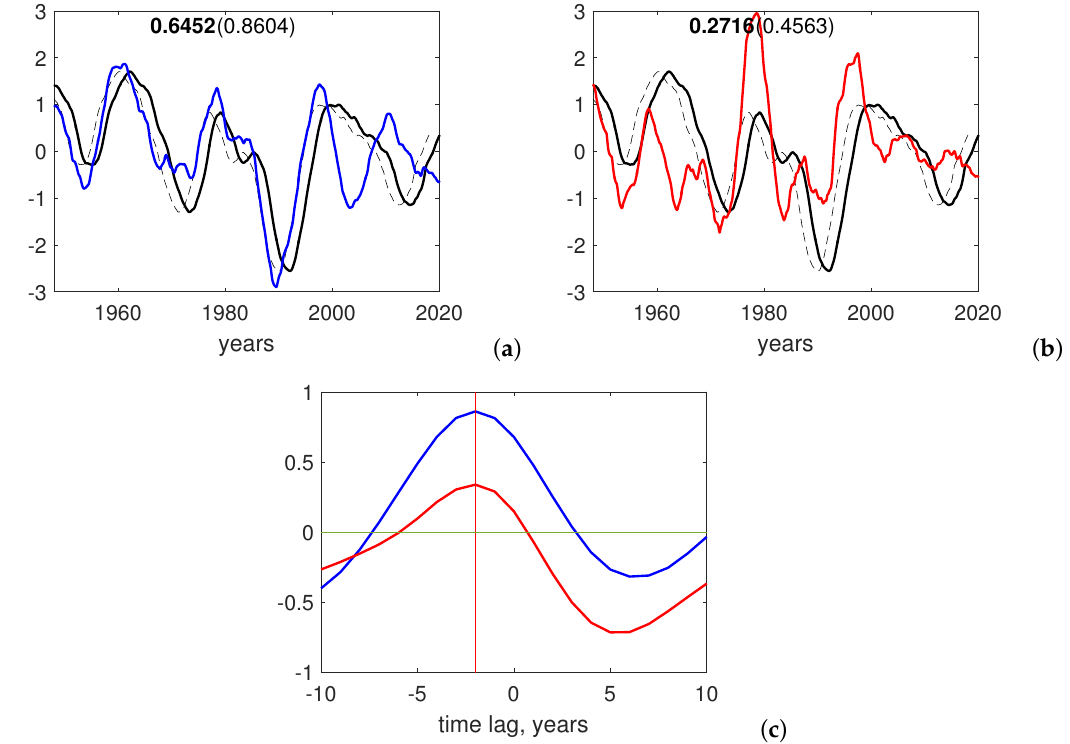
Figure 10. Time change in the rate of total ice growth averaged over the selected areas in comparison with the time variations of the third EOF mode principal component (black): ( a ) the ice growth rate in the region A (blue), ( b ) the rate of decrease in ice thickness in the region B (red), ( c ) the value of the correlation coefficient of these time-series with the principal component depending on the time lag (in years). The geographical position of the areas is shown in Figure 5i. The dashed black line represents the principle component shifted in time by an amount corresponding to the maximum correlation. The first number from the graphs indicates the correlation coefficient of the main series, the second, in brackets, when there is an optimal lag